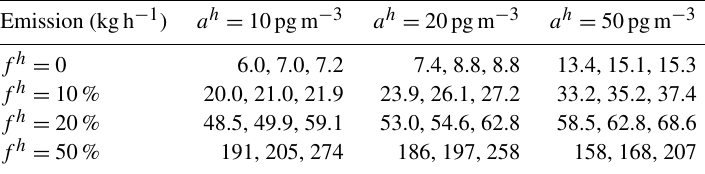
Table 9. The third (25th percentile), fifth (median), and seventh (75th percentile) emission strengths of nine simulations of release 2 that minimize normalized F defined in Eq. (5) for different f h and a h . Logarithm concentration is taken as the metric variable. ((cid:15) ln (c)